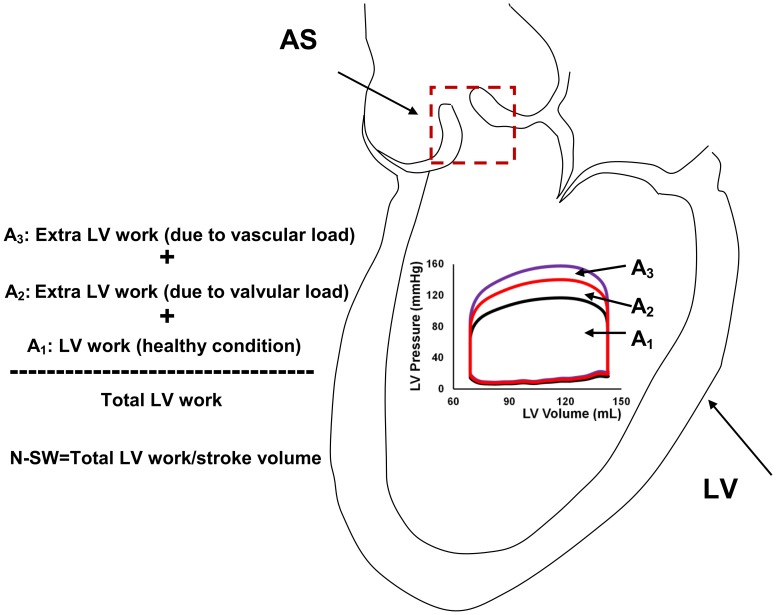
Schematic diagram.LV stroke work and N-SW.